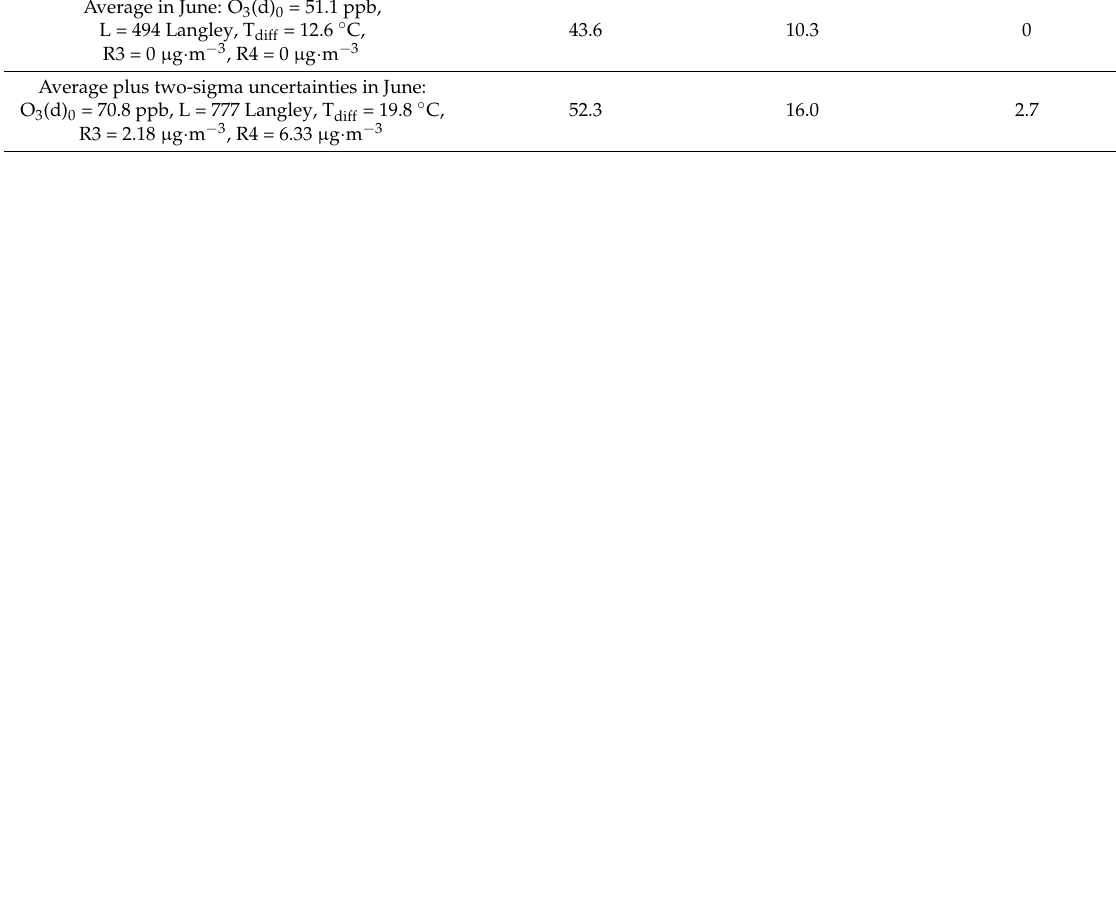
Table 3. Contributions of different terms in the model to the eight-hour daily maximum O 3 concentrations for non-rainy days at various scenarios. O 3 Due to Previous Day O 3 Due to Solar O 3 Due to R4 (Episodic O 3 Due to R3 (Episodic O 3 Due to Interactions Total O 3 Scenarios and Seasonal Effect (ppb) Radiation (ppb) Industrial Emissions) (ppb) Fire Emissions) (ppb) of R3 and R4 (ppb) (ppb) Average in April: O 3 (d) 0 = 51.6 ppb, L = 358 Langley, T diff = 13.8 ◦ C, Average plus two-sigma uncertainties in April: O 3 (d) 0 = 73.4 ppb, L = 660 Langley, T diff = 24.2 ◦ C, Average in June: O 3 (d) 0 = 51.1 ppb, L = 494 Langley, T diff = 12.6 ◦ C, Average plus two-sigma uncertainties in June: O 3 (d) 0 = 70.8 ppb, L = 777 Langley, T diff = 19.8 ◦